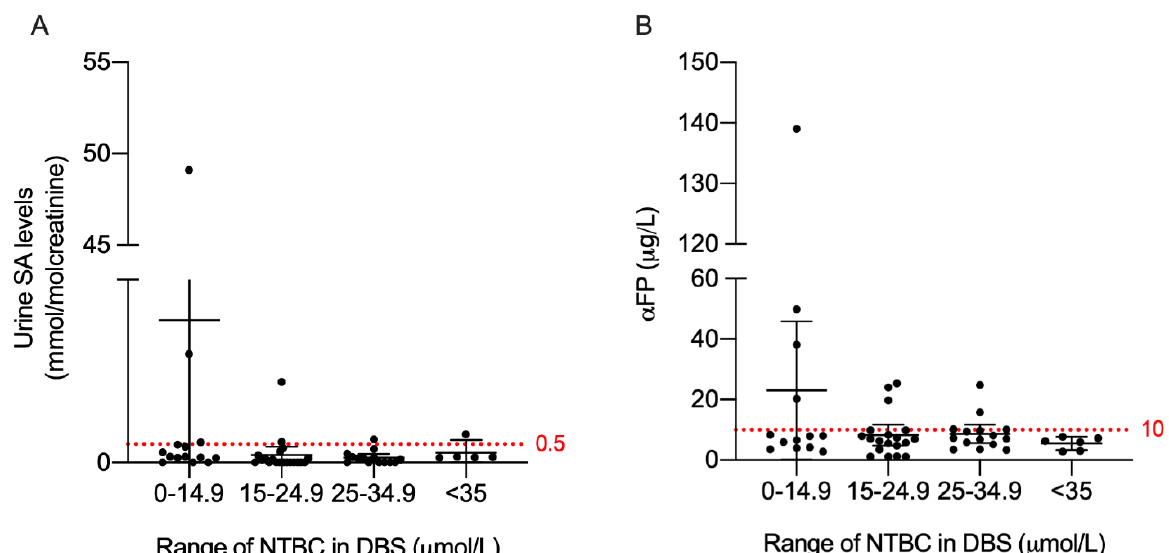
Figure 2. NTBC concentration ranges associated with SA excretion in urine and α FP in plasma. Graph ( A ): SA; Graph ( B ): α FP. Dotted lines represent the maximum allowable concentration: SA, 0.5 mmol/mol creatinine in urine; α FP, 10 µ g/L in plasma. NTBC, Nitisinone; DBS, Dried blood Spot; SA, Succinylacetone; α FP, alpha-fetoprotein. Table 3. The mean of SA and α FP levels according to the NTBC concentration range in blood samples. Range of NTBC